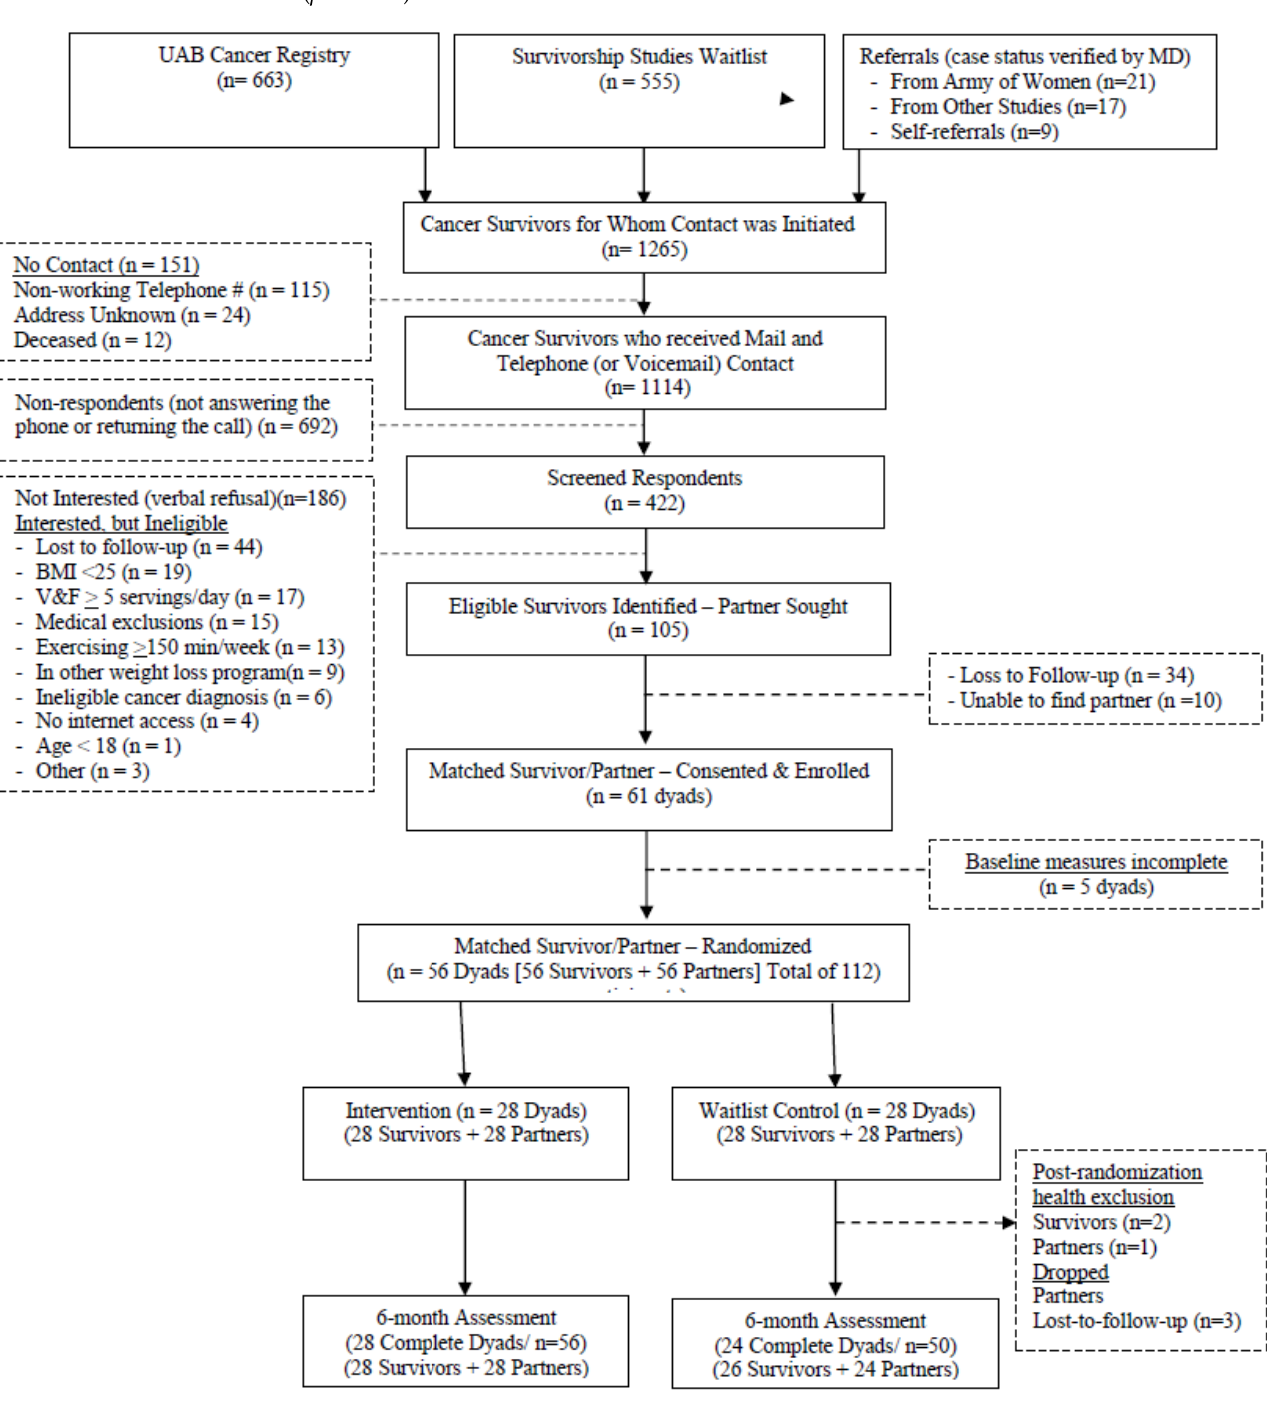
Figure 1. DUET CONSORT diagram.